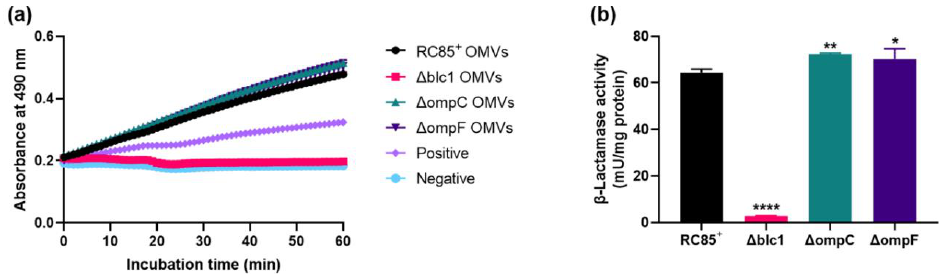
Figure 4. Investigation of the differences in β-lactamase activity between destroyed OMVs from RC85 + and isogenic mutant strains of RC85 + (Δblc1, ΔompC, and ΔompF). ( a ) β-Lactamase activity profiles of samples were measured in a kinetic mode in 60 min. Data are representative of three independent experiments in means ± SEMs. ( b ) β-Lactamase units were normalized to milligrams of total OMV protein. The data are presented as means and SEMs of three independent experiments. * p < 0.05, ** p < 0.01, and **** p < 0.0001.